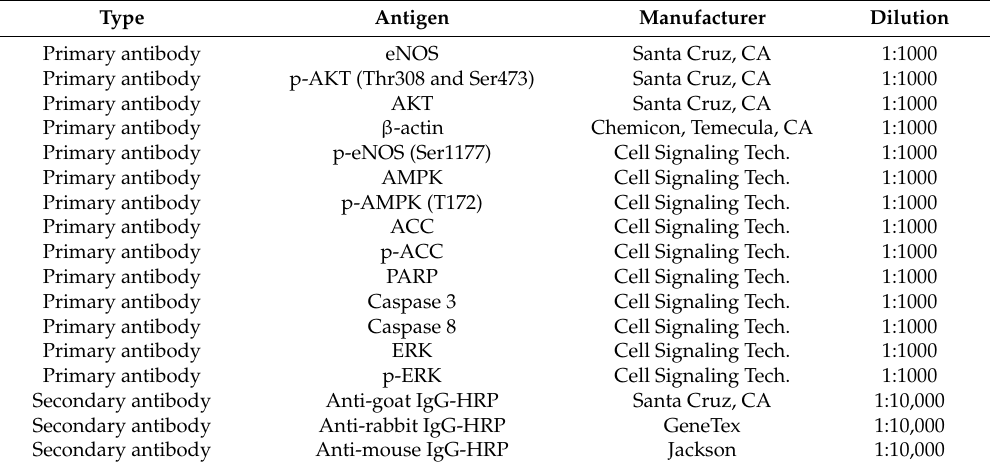
Table 1. Antibodies used for Western